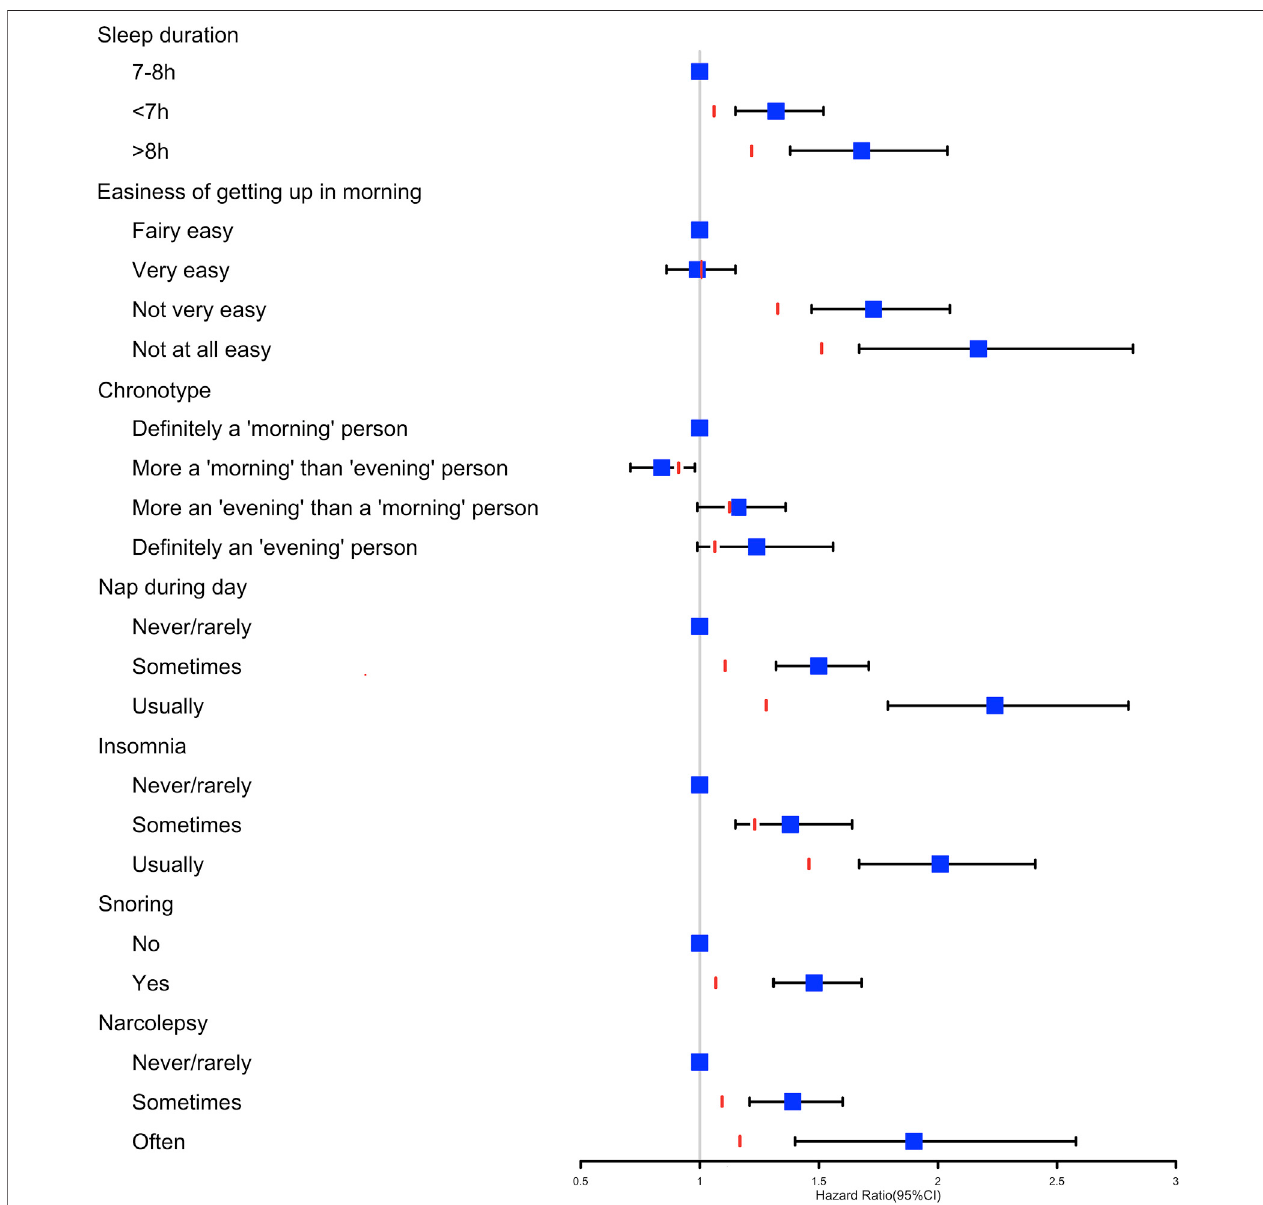
FIGURE 1 | Cox proportional hazards model adjusted by age and sex analysis used to determine the association between the seven sleep traits and nonalcoholic fatty liver disease. The red line represents the HR estimates of the fully adjusted model 3 for each sleep variable.